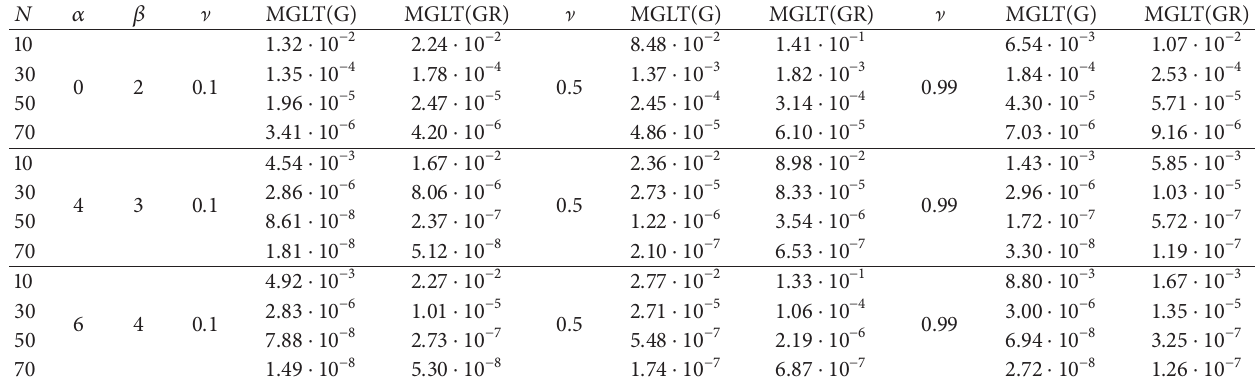
Table 1: Maximum absolute error, with various choices of 𝑁 , for Example 4 in which 𝑥 ∈ [0, 10] .